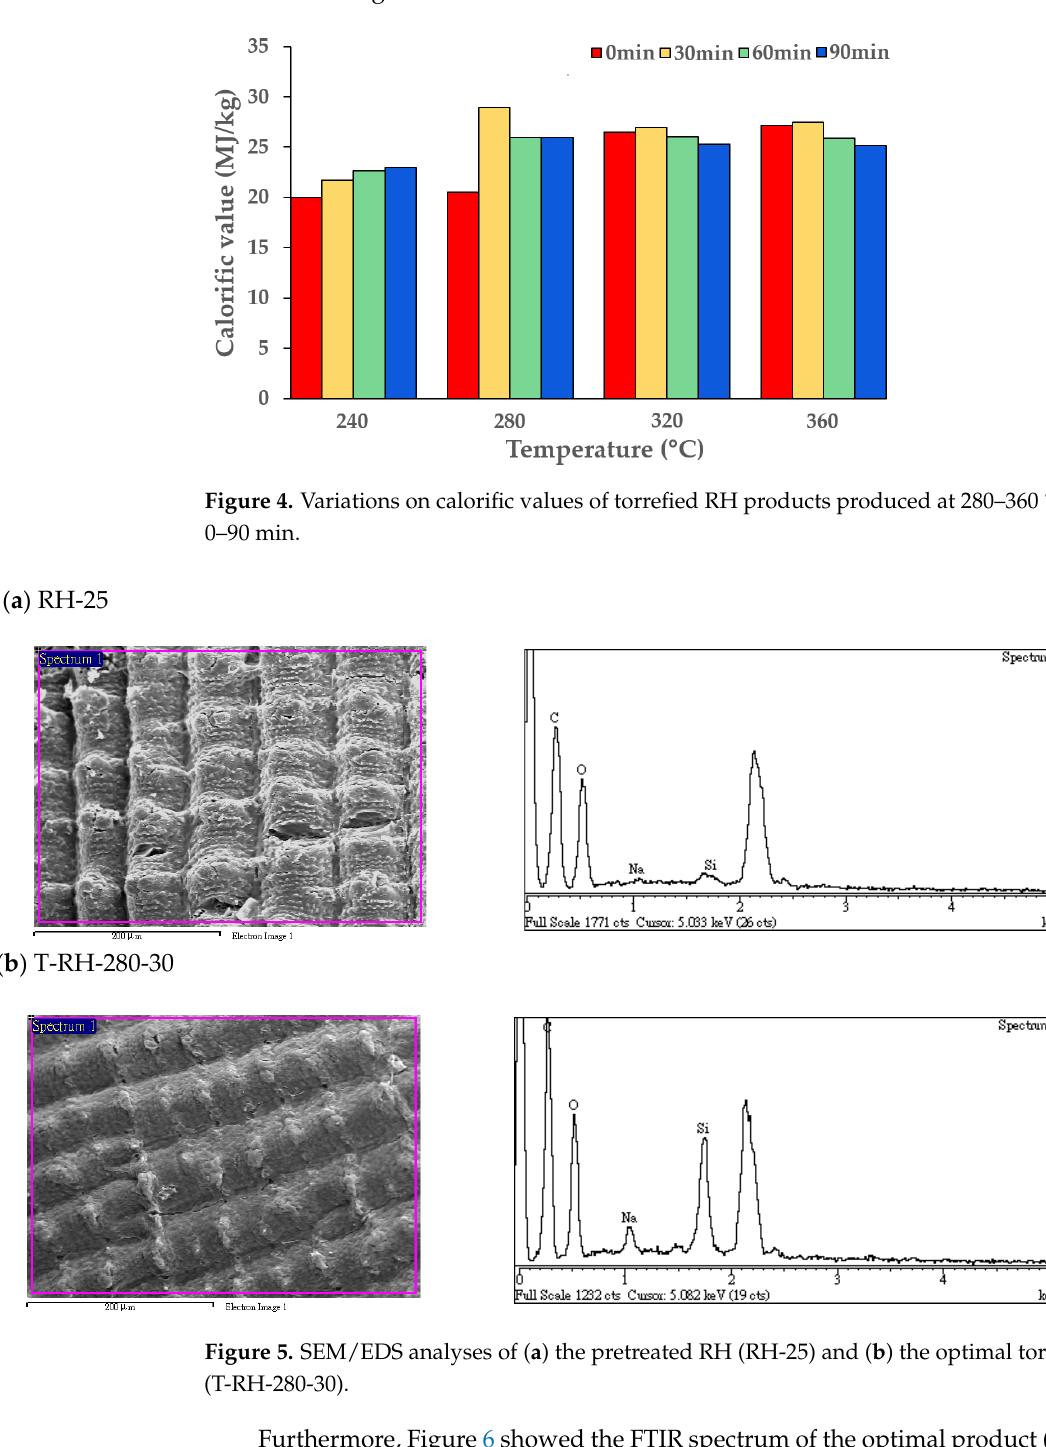
Figure 4. Variations on calorific values of torrefied RH products produced at 280–360 °C for hold- ing 0–90 min.